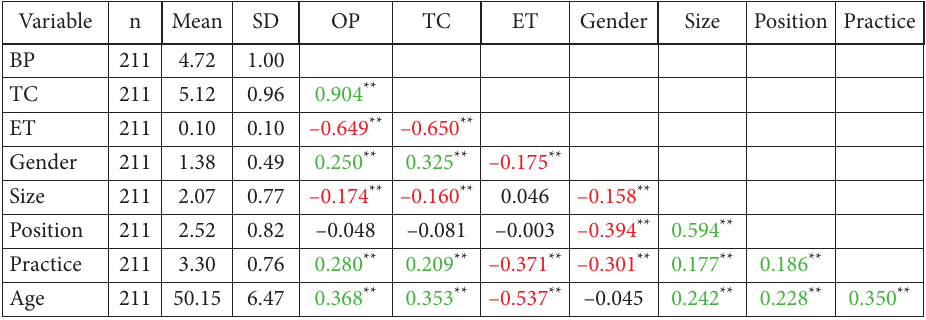
Table 4. The correlation matrix (source: own research)